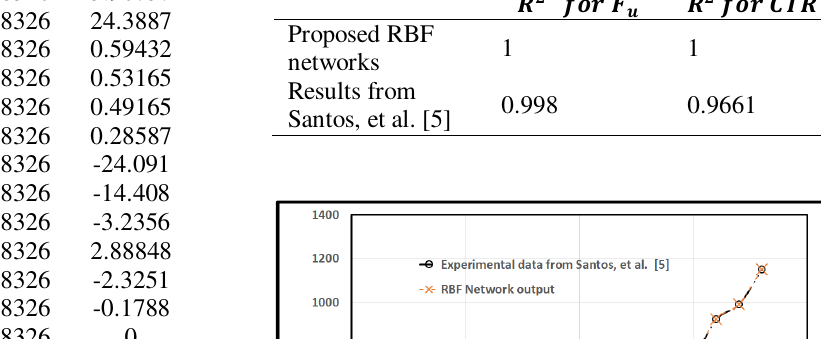
versus from [5] . T P T P